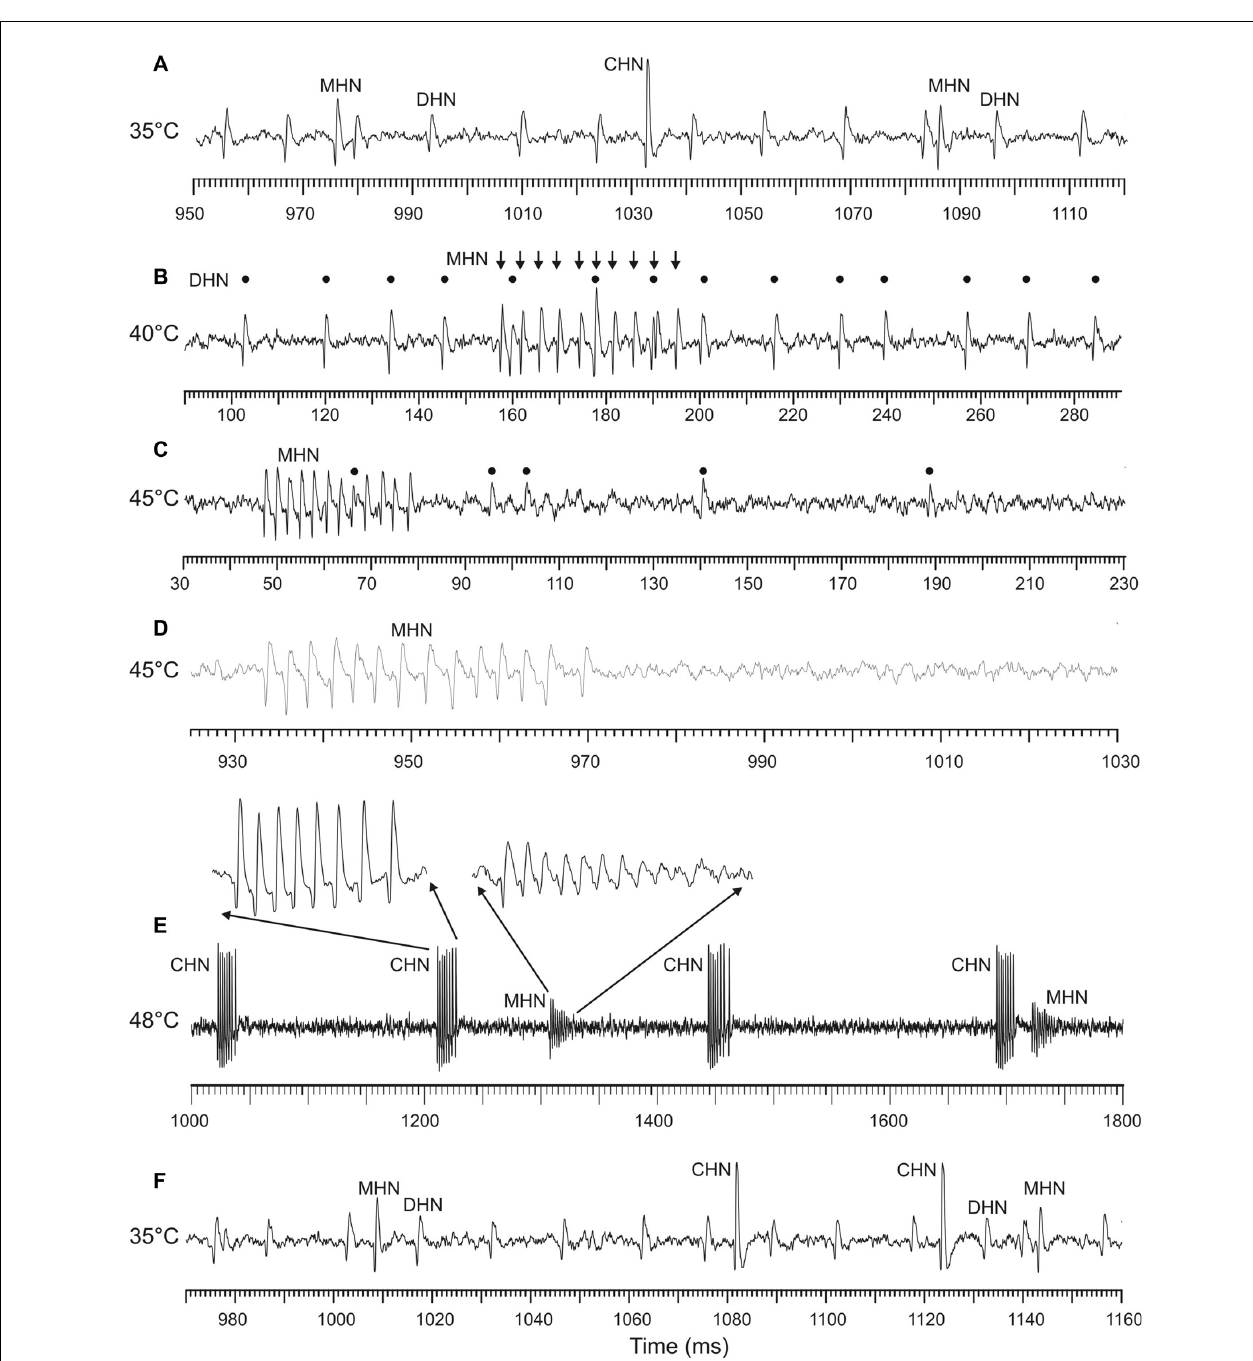
FIGURE 5 | Sample recordings from an antennal DSS, demonstrating degradation of spike waveforms produced by the DHN and MHN at the high end of noxious heat. All the recordings were obtained from the same sensillum. (A) At 35 ◦ C, in this particular sensillum, all the three neurons fired in a regular manner and displayed normal spike shapes. (B) At 40 ◦ C, the MHN switched from regular spiking to spike bursting (arrows), the CHN stopped spike production, while the DHN continued regular firing (black dots). When stimulating temperature was raised to 45 ◦ C, spike amplitude of the DHN gradually decreased (C) and then fully disappeared (D) while the MHN continued burst firing by normal spikes (C,D) . No spiking activity was observed in the CHN. Note that the spike train fragments (C,D) originate from the same 18-s recording. (E) When the stimulating temperature was increased further (48 ◦ C), spike bursts of the MHN began to degrade also; only the first spike in a burst was of normal amplitude followed by spikes with gradually diminishing amplitude up to the noise level. The DHN remained inactive. By contrast, the CHN became active again, producing high-frequency spike bursts consisting of spikes with normal shape. (F) After cooling of the DSS to the initial temperature of 35 ◦ C, the DHN and the MHN fully recovered from their high temperature-induced spike shape degradation, demonstrating that the observed changes in spike waveforms were reversible.